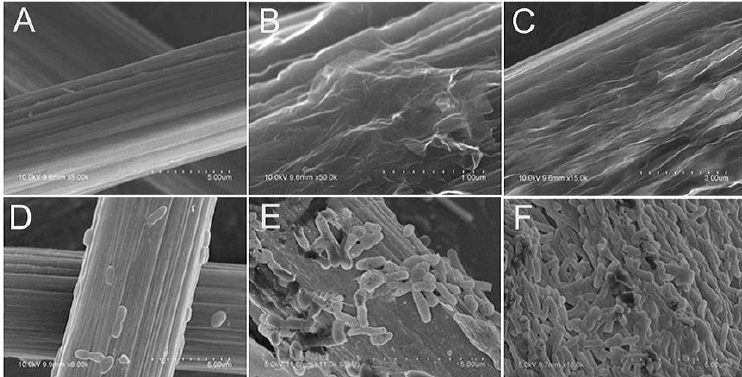
Figure 7. SEM images of carbon paper (CP) ( A , D ); graphene nanosheets modified carbon paper (GNS/CP) ( B , E ); and graphene nanosheets modified carbon paper with a positively charged ionic liquid (IL-GNS/CP) ( C , F ) electrodes before and after S. oneidensis cells attached on the surface of the anodes. Adapted from [21], with permission from © 2013 The Royal Society of Chemistry.